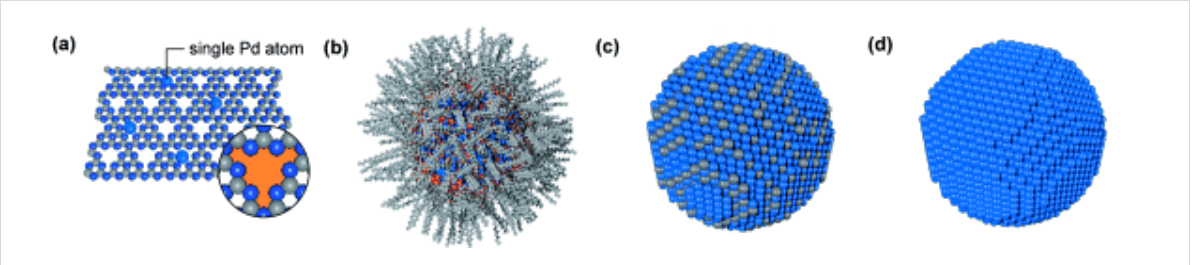
Figure 4: Structure of Pd@mpg-C3N4 (a), Pd(HHDMA)@C (b), Pd(Pb)@CaCO 3 (c) and Pd@Al 2 O 3 (d) catalysts. The structures depict the increas- ing size of the active ensemble, from a single Pd atom (a) to a bare PdNP of approximately 800 atoms (d). The inset in (a) shows a characteristic six-fold cavity (orange) in the carbon nitride structure. C light grey, N dark blue, O red, Pb grey, Pd light blue. Adapted with permission from [122] , © 2015 John Wiley and